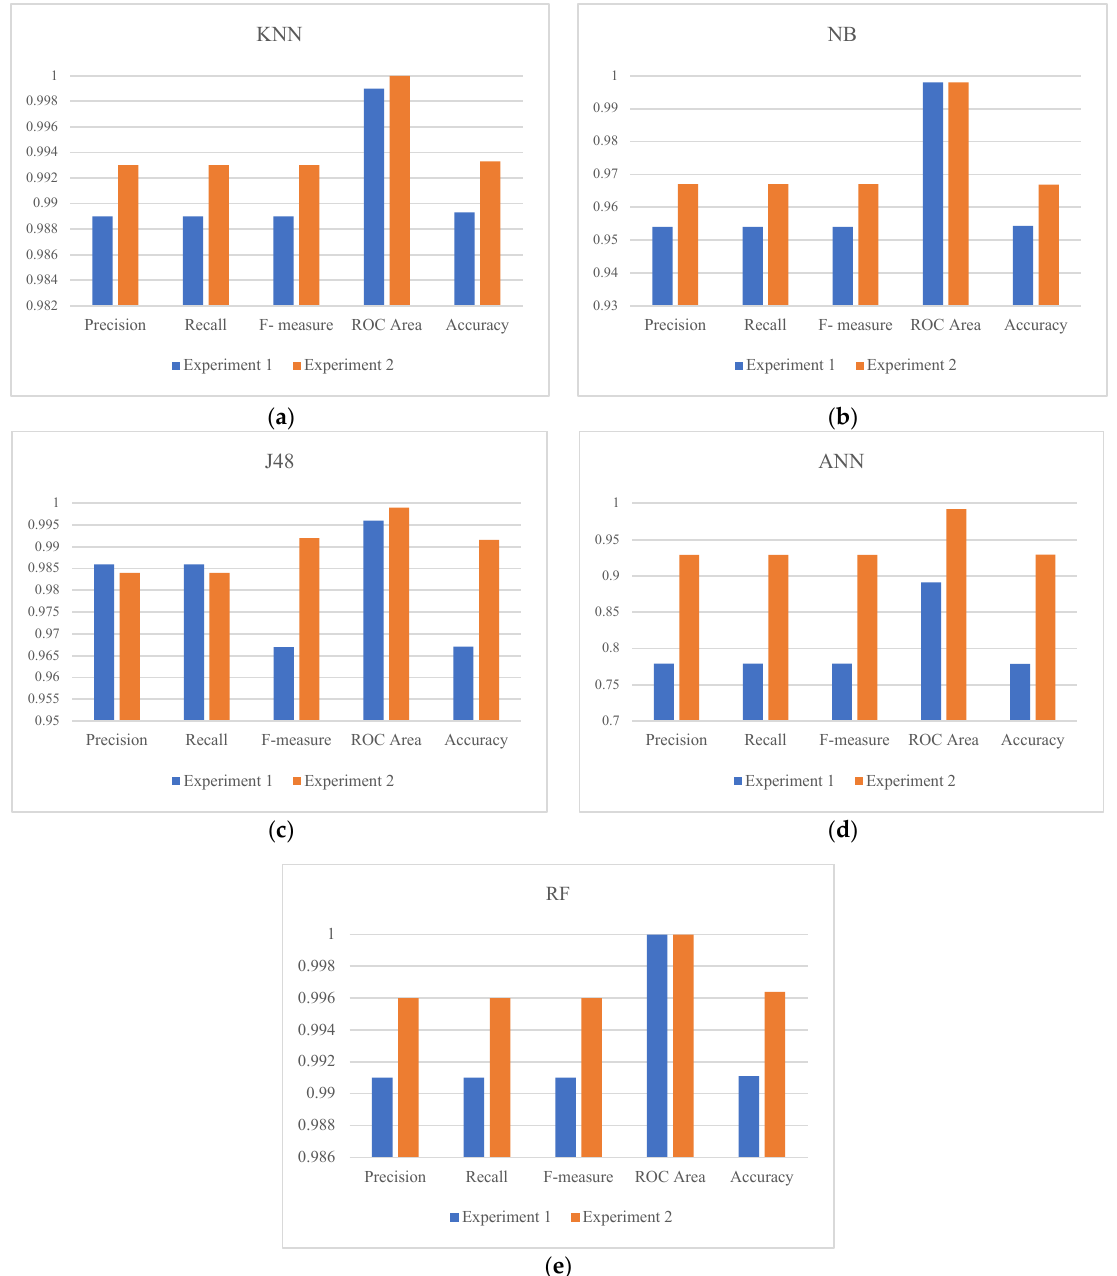
0.9860.9880.990.9920.9940.9960.998 Figure 4. Comparison between results achieved in the first and the second experiment by each of the classifiers. ( a ): Performance analysis of the KNN classifier ( b ): Performance analysis of the NB classifier ( c ): Performance analysis of the J48 classifier ( d ): Performance analysis of the ANN classifier ( e ): Performance analysis of the RF classifier. Figure 5. Comparison between the achieved accuracy for all classifiers in the second experiment. To get a better evaluation, the confusion matrix was considered. Figures 6 and 7 show the confusion matrix when using the RF classifier, showing the number of correctly clas- sified instances for both experiments.